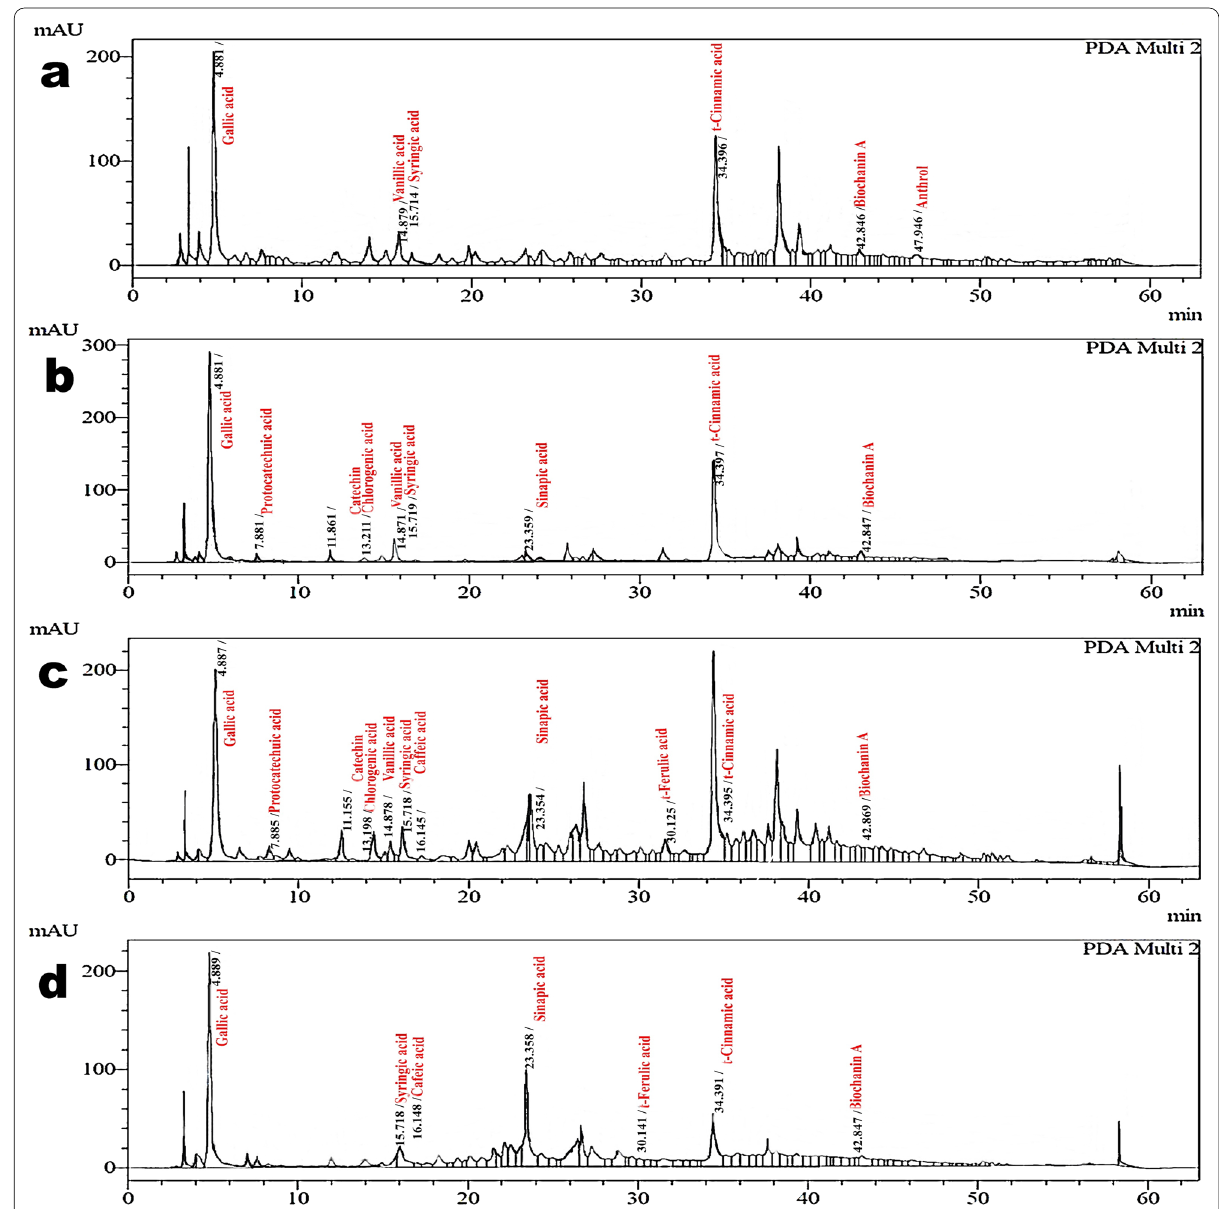
Fig. 4 Chromatograms of ethyl acetate extracts of four species of Saraca a S. asoca , b S. declinata , c S. indica and d S .